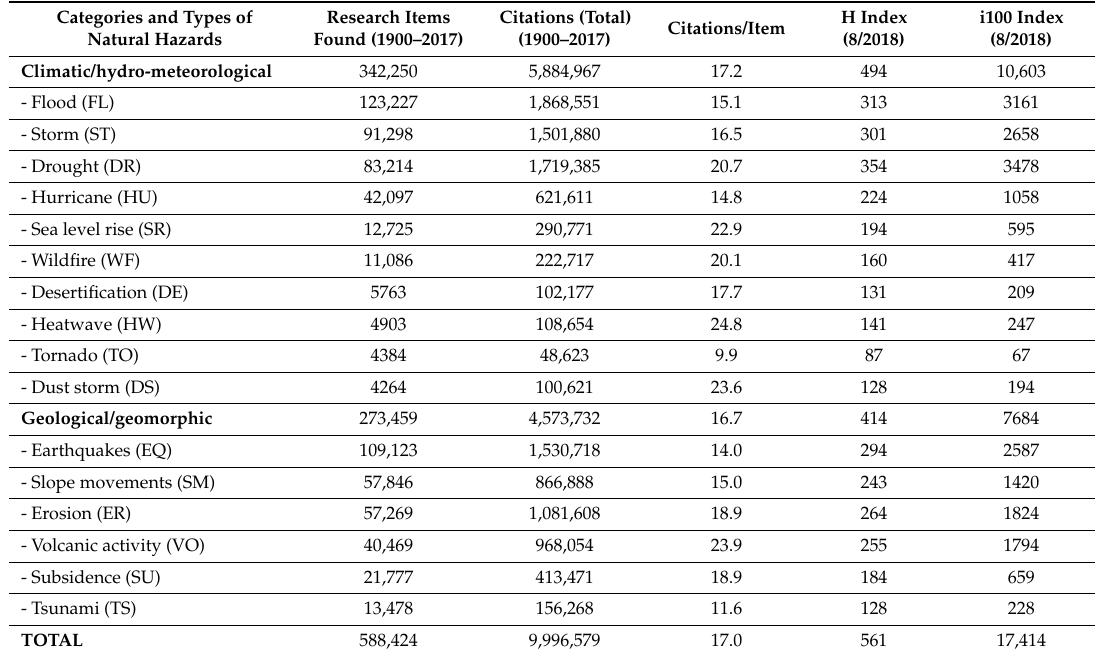
Table 5. Total number of citations obtained by research items of individual types of natural hazards, average citations per item, H index, and i100 index (in August